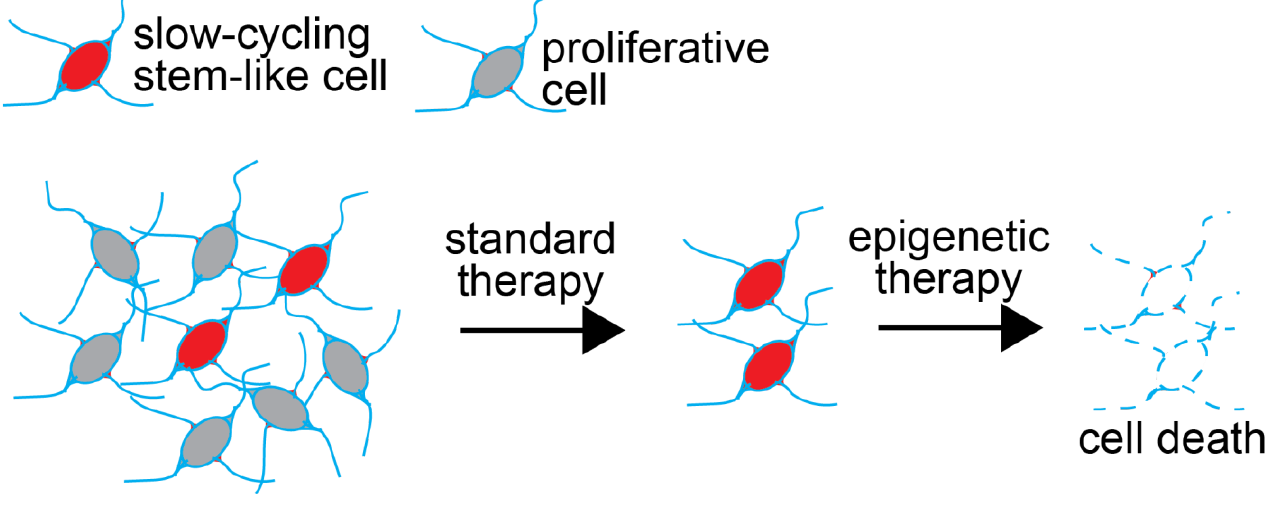
Figure 1. Strategy to deploy epigenetic therapy to target cancer stem cells. Standard therapy (e.g., radiation and most chemotherapies) often consists of treatments that aim to kill actively proliferating cells. These therapies may not eradicate the cancer stem cell population because of its slow cycling behaviour. Combining standard of care approaches with epidrugs designed to target essential epigenetic programs in cancer stem cells could result in the demise of this refractory cell population. This could be achieved in a proliferation-independent way.